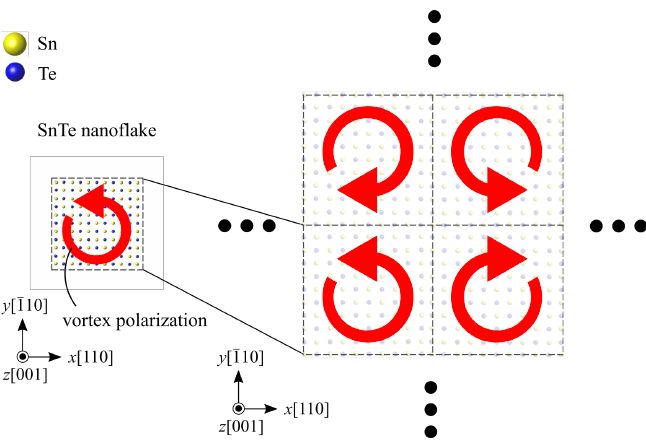
Figure 9. Simulation model of the edge-free SnTe with periodic polarization vortices. Red arrows indicate the direction of vortex polarization.